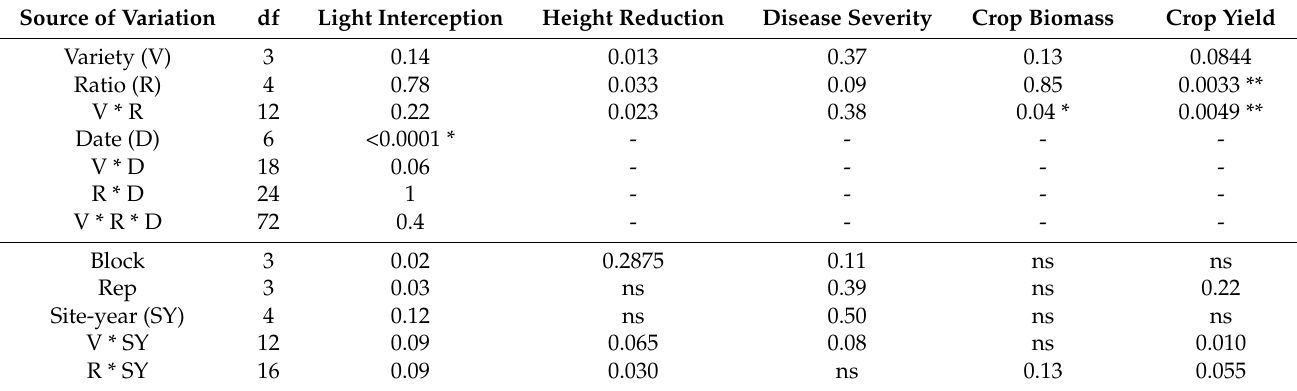
Table 4. ANOVA table light interception, lodging height index, disease severity, crop biomass,